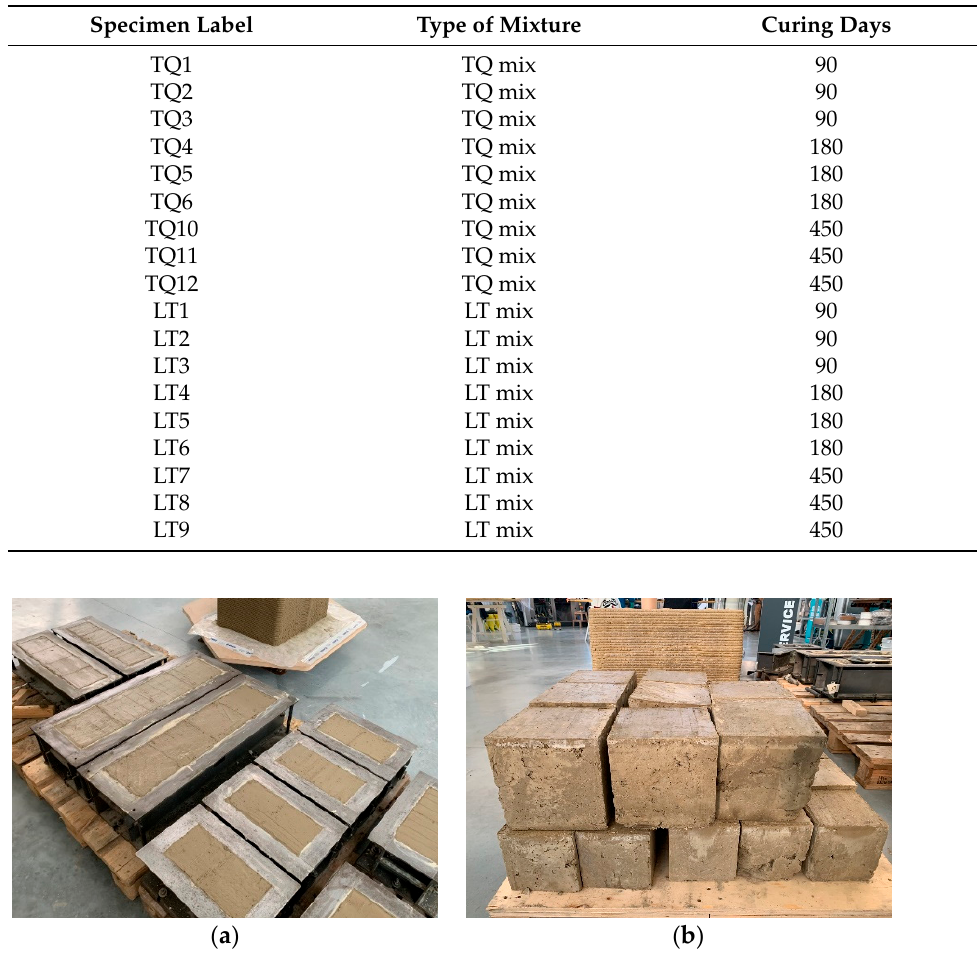
Table 3. List of the specimens of the experimental program (after the elimination of the discarded specimens).